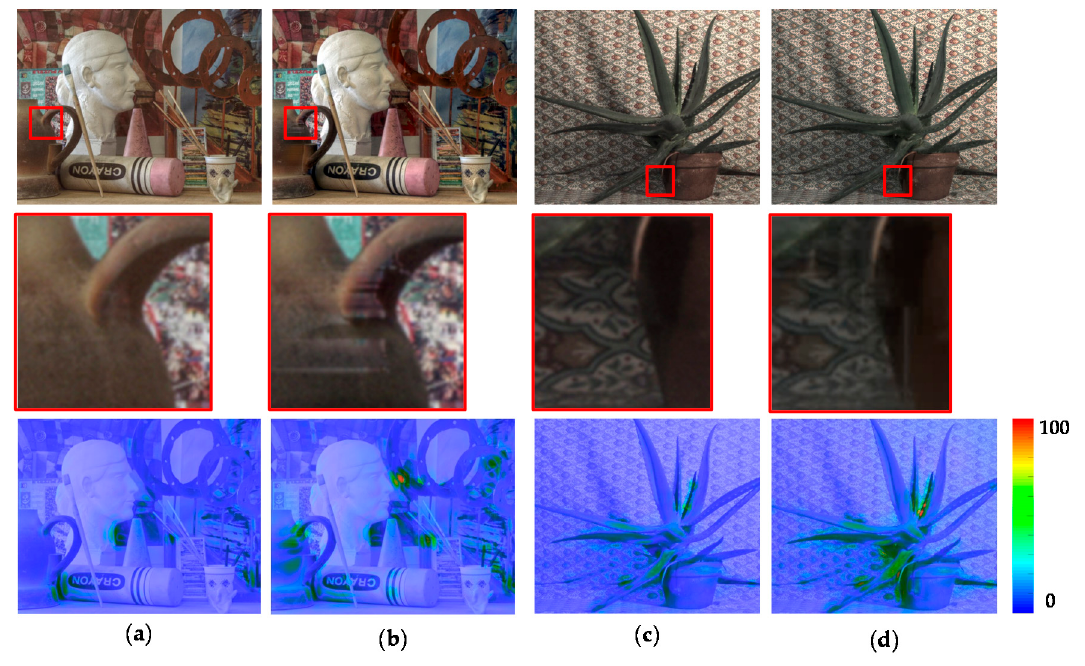
Figure 23. Resultant LDR images (first row) and their magnified sub-regions (second row) obtained with or without Poisson image editing (PIE): ( a , c ) with PIE; and ( b , d ) without PIE. Color-coded HDR-VDP2 maps (last row) are provided for a better performance comparison.